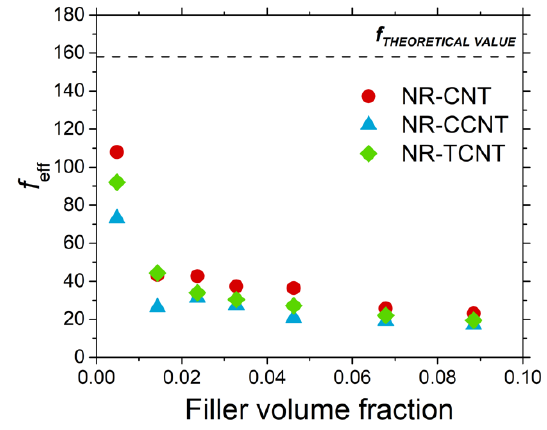
Figure 14. Effective shape factor of the studied rubber compounds.